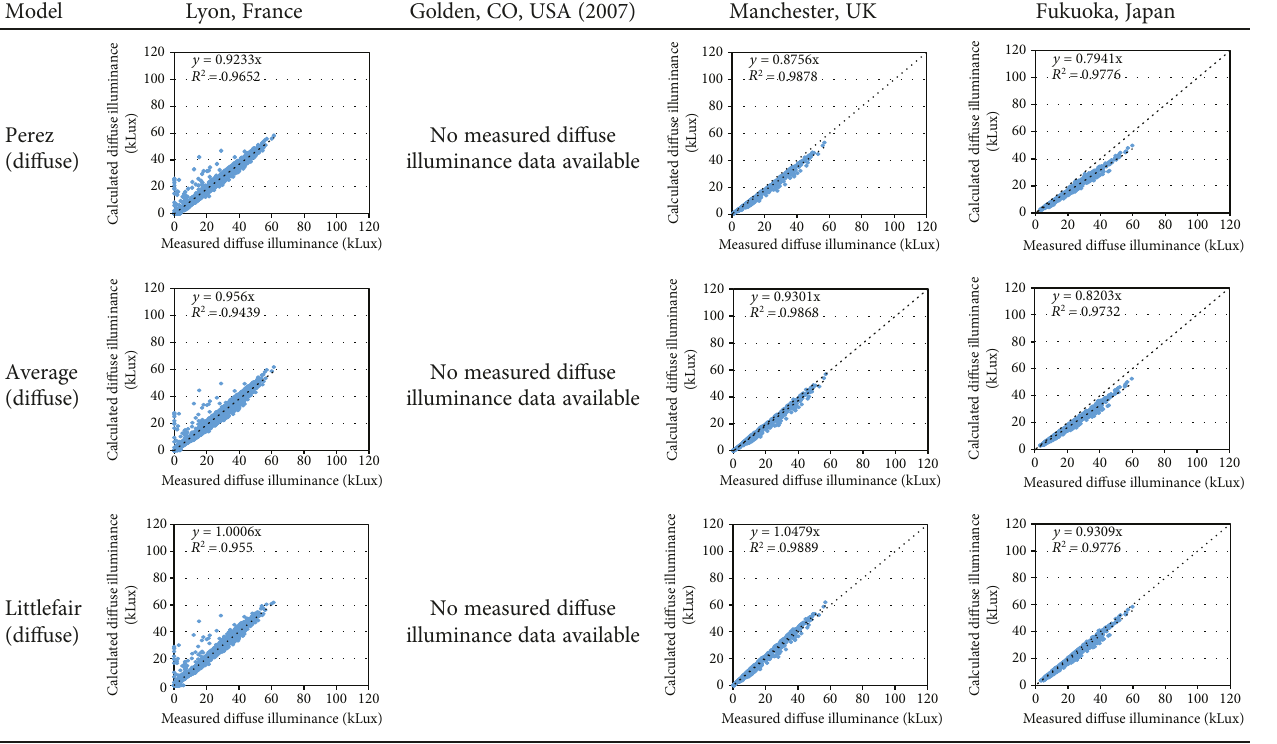
Table 5: Comparative analysis of di ff use luminous e ffi cacy models ’ performance for four worldwide cities.